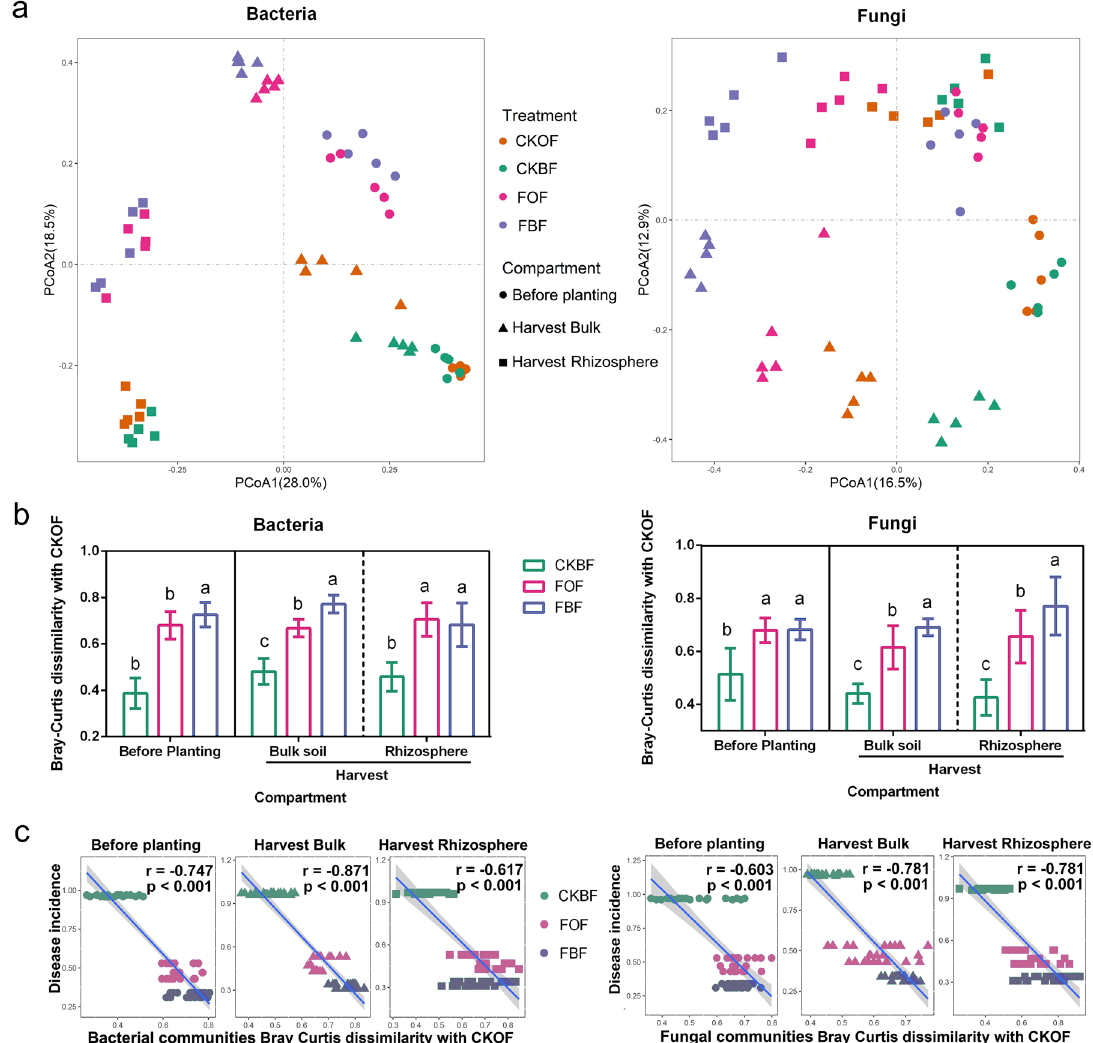
Fig. 4 Bacterial and fungal community composition. a Principal coordinate analysis (PCoA) ordinations of the bacterial and fungal community composition based on Bray-Curtis distance metric in all soil samples. CKOF: organic fertilizer was amended in un-fumigated soil; CKBF: bio-organic fertilizer was amended in un-fumigated soil; FOF: organic fertilizer was amended in fumigated soil; FBF: bio-organic fertilizer was amended in fumigated soil. Circles refer to the samples before planting, triangles refer to the samples of bulk soil at harvest, and squares refer to the rhizosphere samples at harvest. b Bray-Curtis dissimilarity of bacterial and fungal communities between CKOF and other treatments. Different letters indicate signi fi cant differences among the four treatments as de fi ned by Tukey ’ s test ( p < 0.05). c Linear regression between Bray-Curtis dissimilarity in relation to the control treatment and disease incidence. r and p value were calculated through spearman correlation.